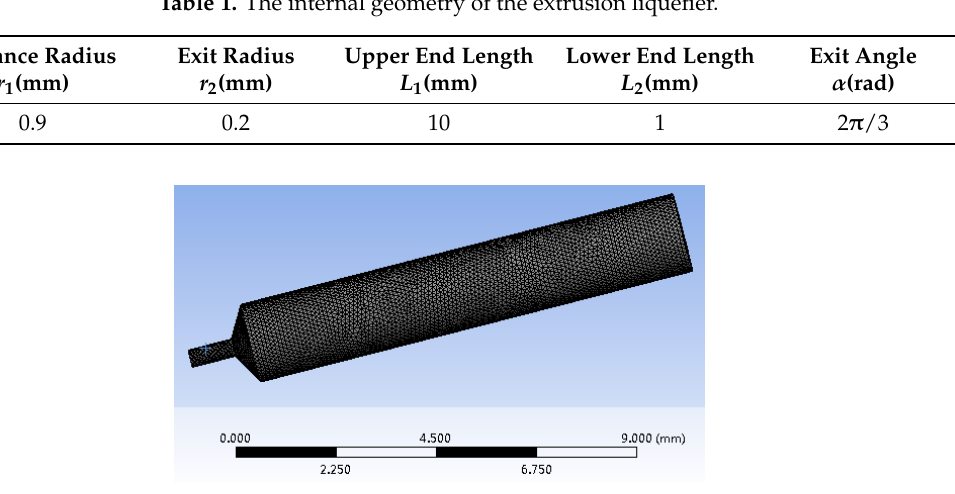
Table 1. The internal geometry of the extrusion liquefier.